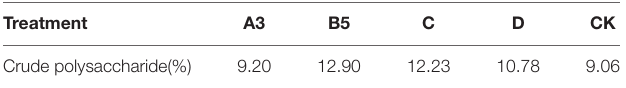
TABLE 4 | Extraction rate of crude polysaccharide from fruiting bodies of different